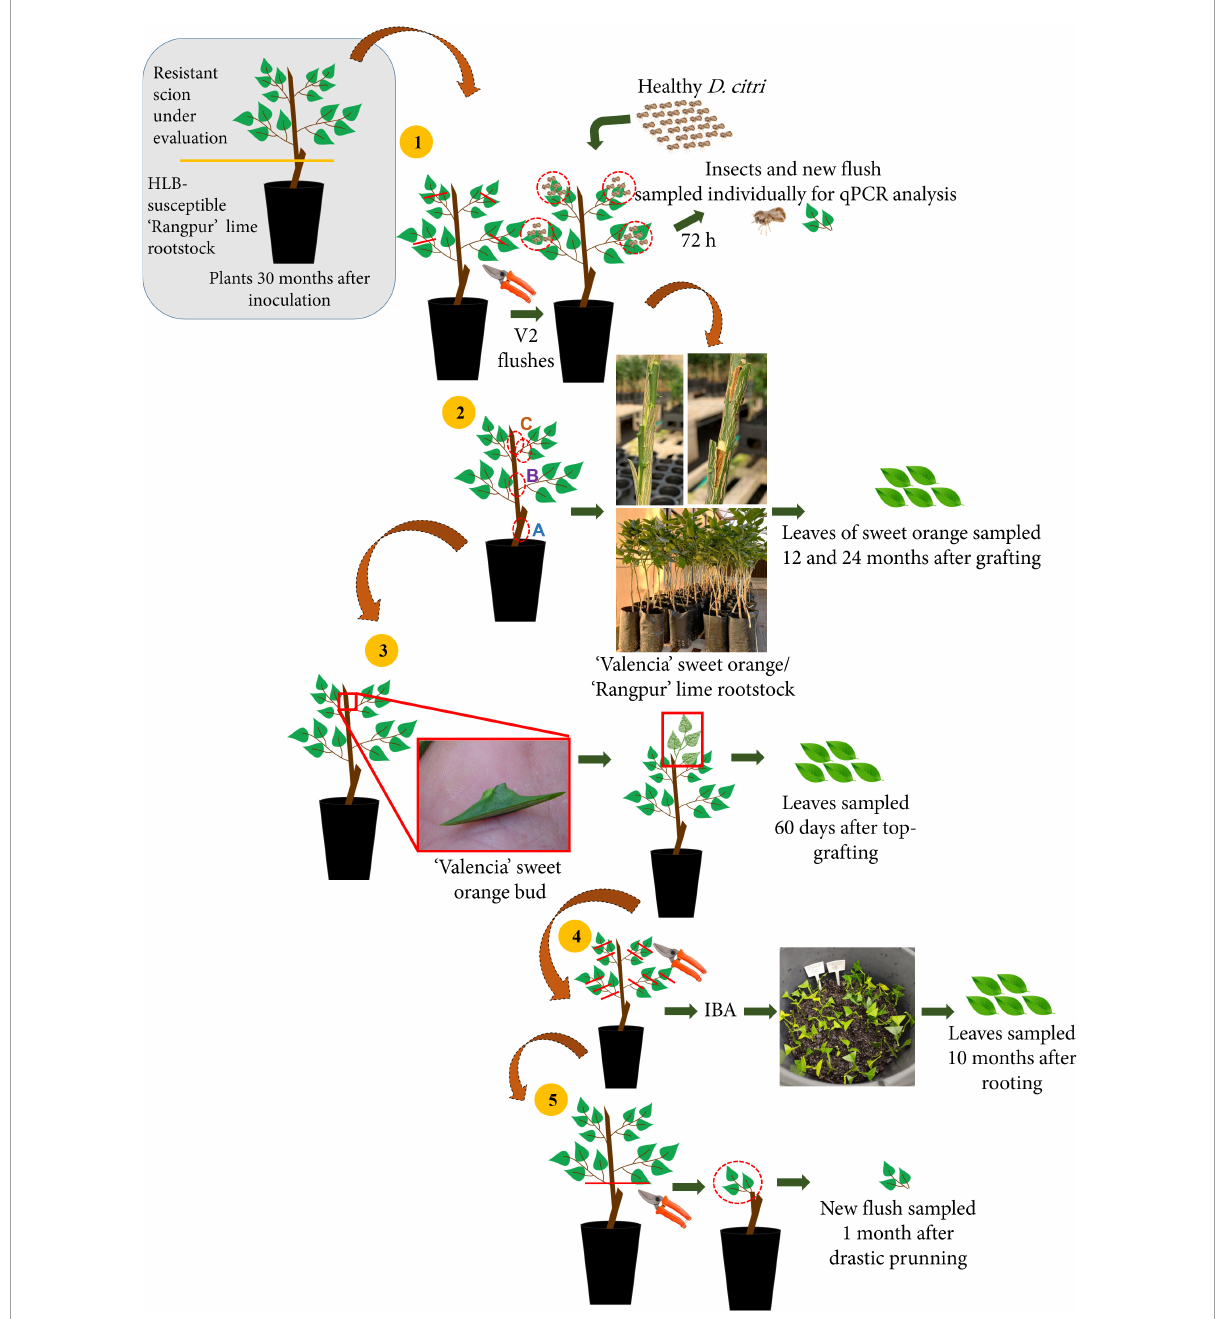
FIGURE1 Schematic design of the five experiments carried out (1) Las acquisition by Diaphorina citri reared on Oceanian citrus genotypes; (2) Las indexing in ‘Valencia’ sweet orange plants grafted with (A) bark tissue from 5 cm below the graft union of Las-infected ‘Rangpur’ lime used as rootstock, (B) bark tissue from 8 cm above the graft union, and (C) budwood from the top of the Oceanian citrus genotypes; (3) Top-grafting of ‘Valencia’ sweet orange plants on scions from the Oceanian citrus genotypes; (4) Las multiplication through stem cuttings of Oceanian citrus genotypes; and (5) Forcing Las colonization from the ‘Rangpur’ lime rootstock to new sprouted shoots of Oceanian citrus genotypes after severe back-pruning.